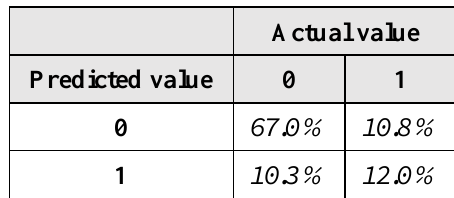
Table 4. Binary logistic confusion